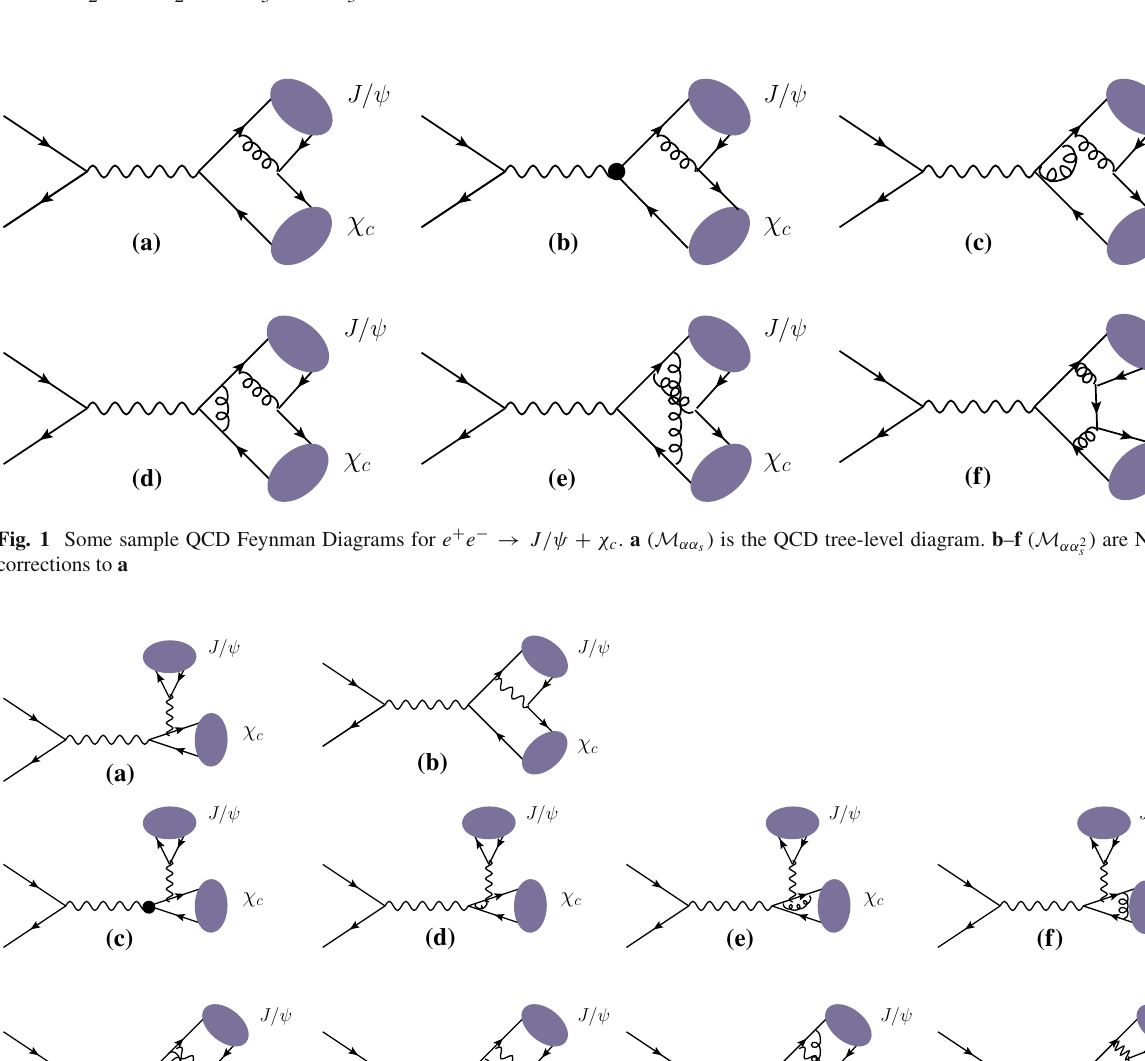
Fig. 2 Some sample QED Feynman Diagrams for e + e − → J /ψ + χ c . a , b ( M α 2 ) are the QED tree-level diagrams, in which a denotes the typical SPF diagram. c – k ( M α 2 α ) are NLO QCD corrections to a , s